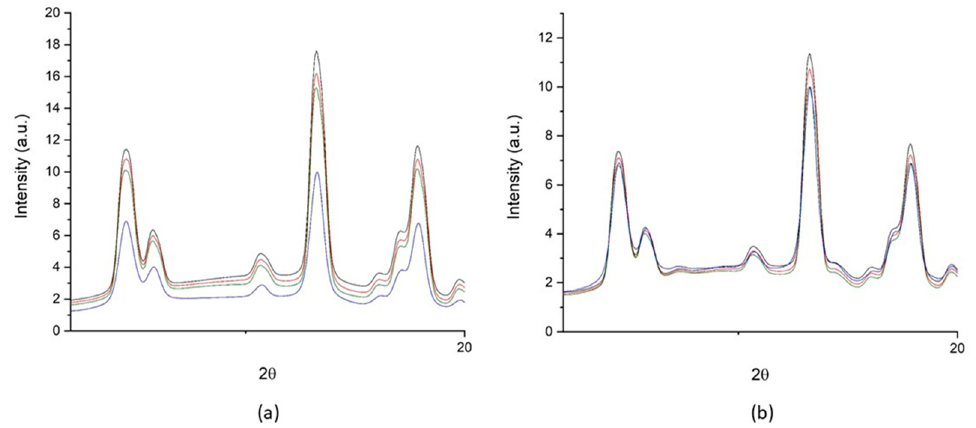
Figure 6. Powder patterns collected for 6 LiM 210 B ( a ) and LiM 2 B ( b ) before neutron radiation (black line), after irradiation with thermal neutron fluences of 1.2 10 10 cm − 2 (red line), 3.6 10 10 cm − 2 (green line) and 1.0 10 11 cm − 2 (blue line).